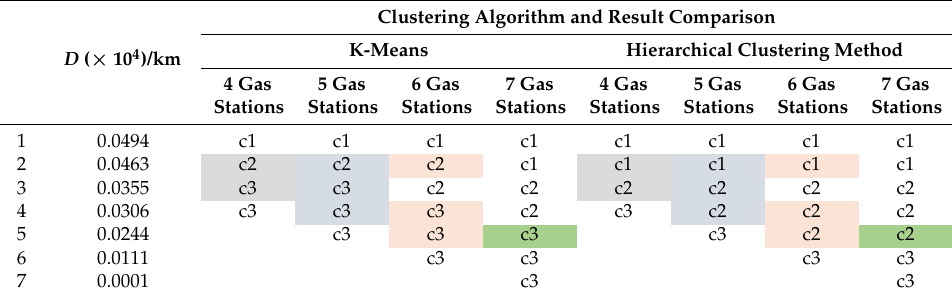
Table 4. The effect comparison of clustering by different clustering